Question: Looking at the figure, what chart type is it?
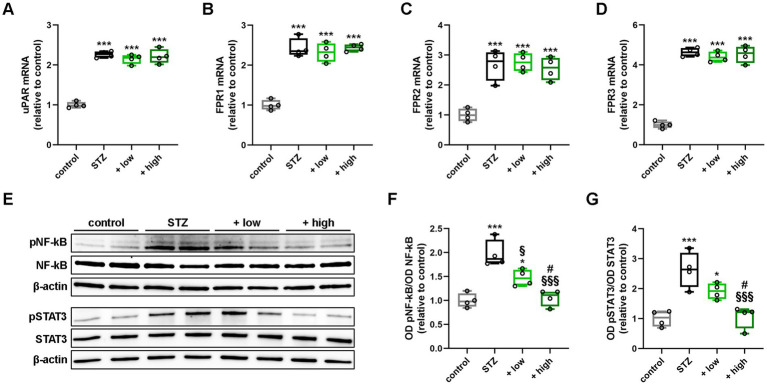
Answer: box